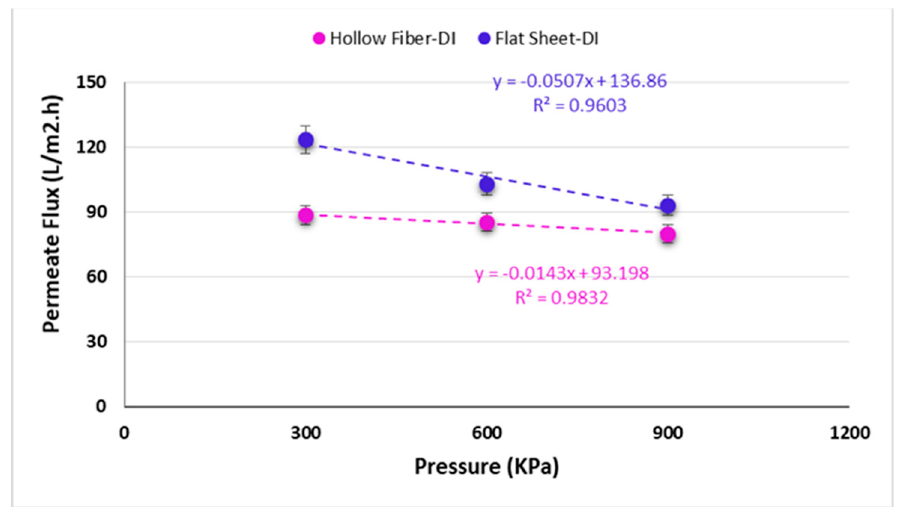
Figure 7. Influence of pressure on permeate flux for two various membrane modules.